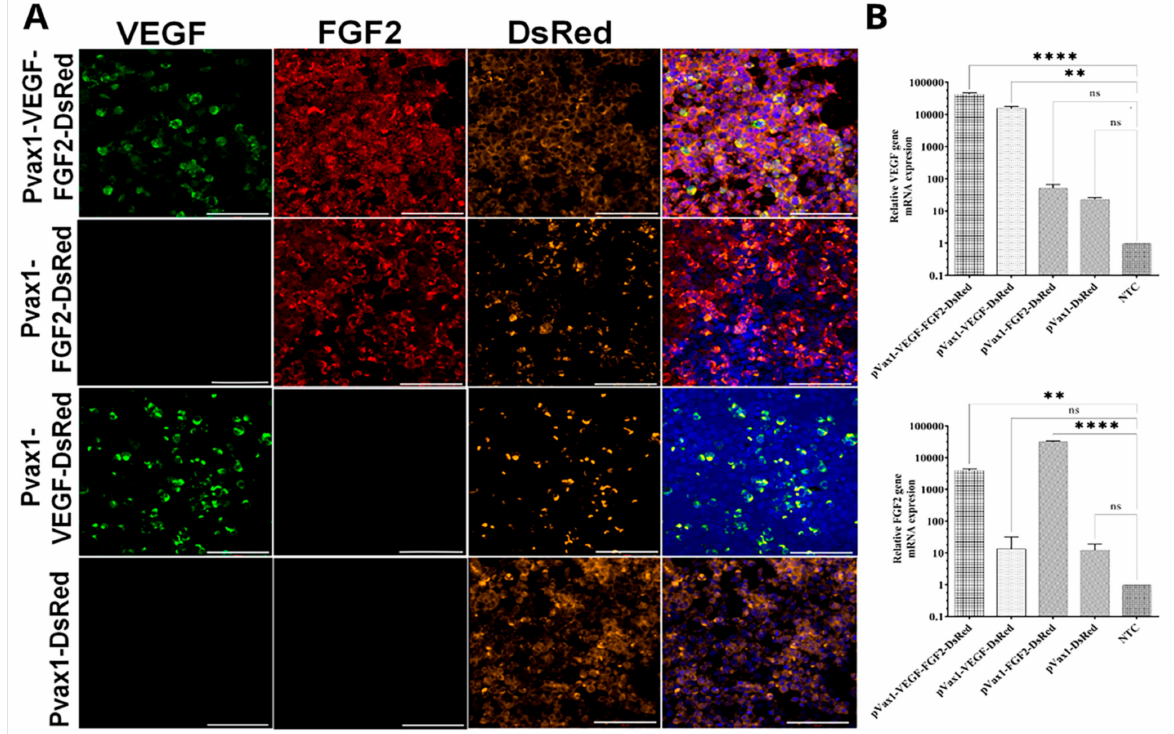
Figure 2. Expression of recombinant angiogenic factors in transfected HEK293T cells. ( A ) Immunofluorescent analysis of genetically modified HEK293T cells. Staining for VEGF (green) and FGF2 (red). Nuclei were counterstained using a DAPI solution (4 (cid:48) ,6-diamidino-2-phenylindole) (blue). Scale bar 100 µ m. ( B ) mRNA expression of target genes (VEGF, FGF2) in HEK293T cells transfected with plasmids pVax1-VEGF-FGF2-Dsred, pVax1-VEGF-Dsred, pVax1-FGF2-Dsred, pVax1-Dsred. mRNA from cells was assayed by RT–PCR and quantified relative to 18S rRNA mRNA levels. mRNA expression in non-transfected cells (NTC) was considered as control. Data presented as average ± s.e.; p < 0.05 * regarded as statistical significant differences ( n = 3; ** p < 0.01; **** p < 0.0001 compared with control;